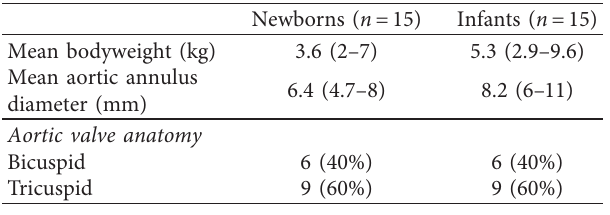
Table 1: Baseline characteristics of enrolled patients with con- genital aortic stenosis.